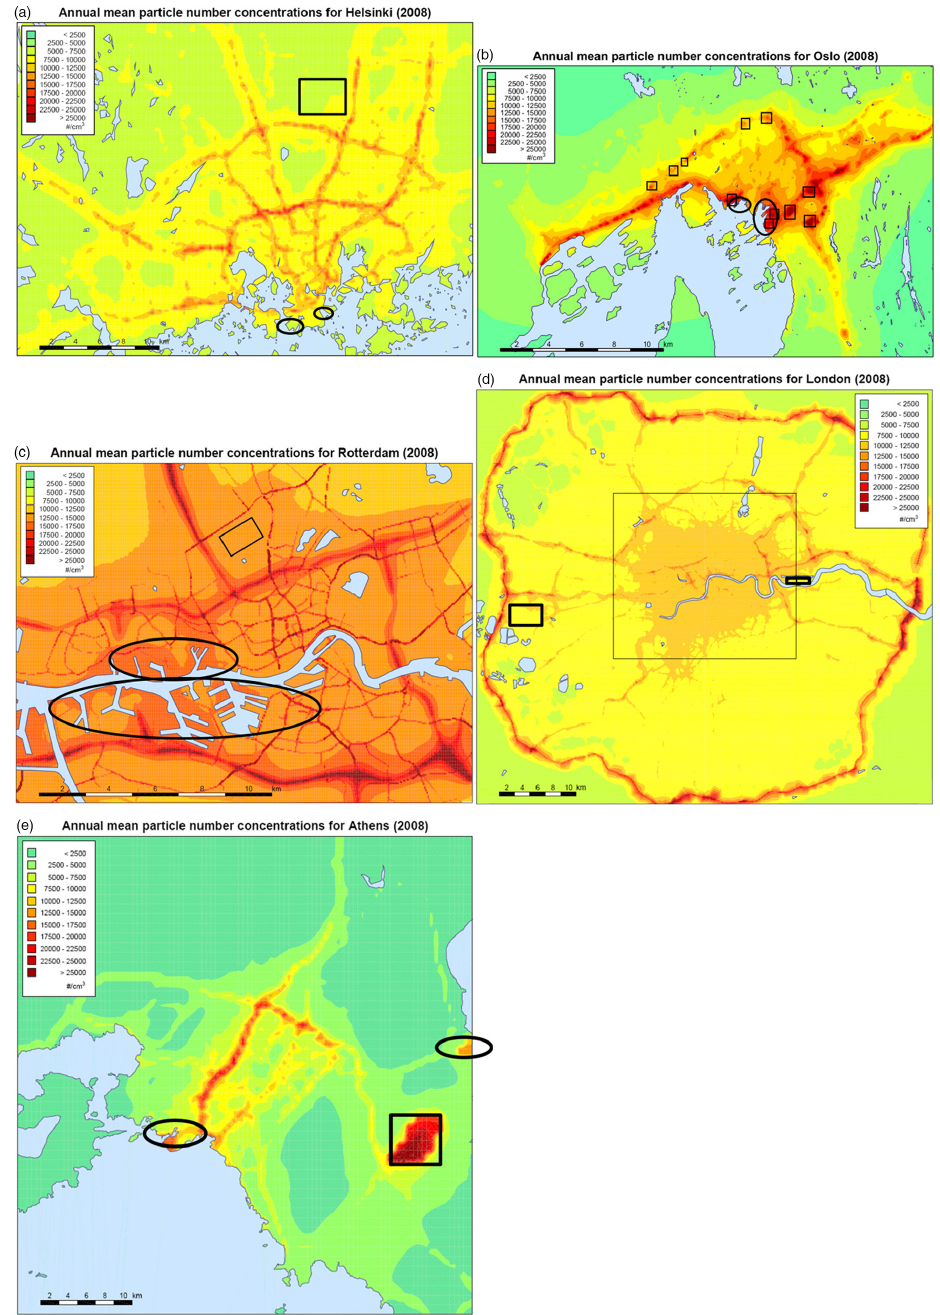
Figure A1. The locations of major harbours, airports, and tunnel entrances in the target cities. The harbour areas have been marked with oval shapes. The airports have been marked with rectangles, except for Oslo, for which the rectangles correspond to the locations of the tunnel entrances. The geographical areas denoted by the shapes in the panels are approximates. (a) – (e) correspond to Helsinki, Oslo, Rotterdam, London, and Athens,